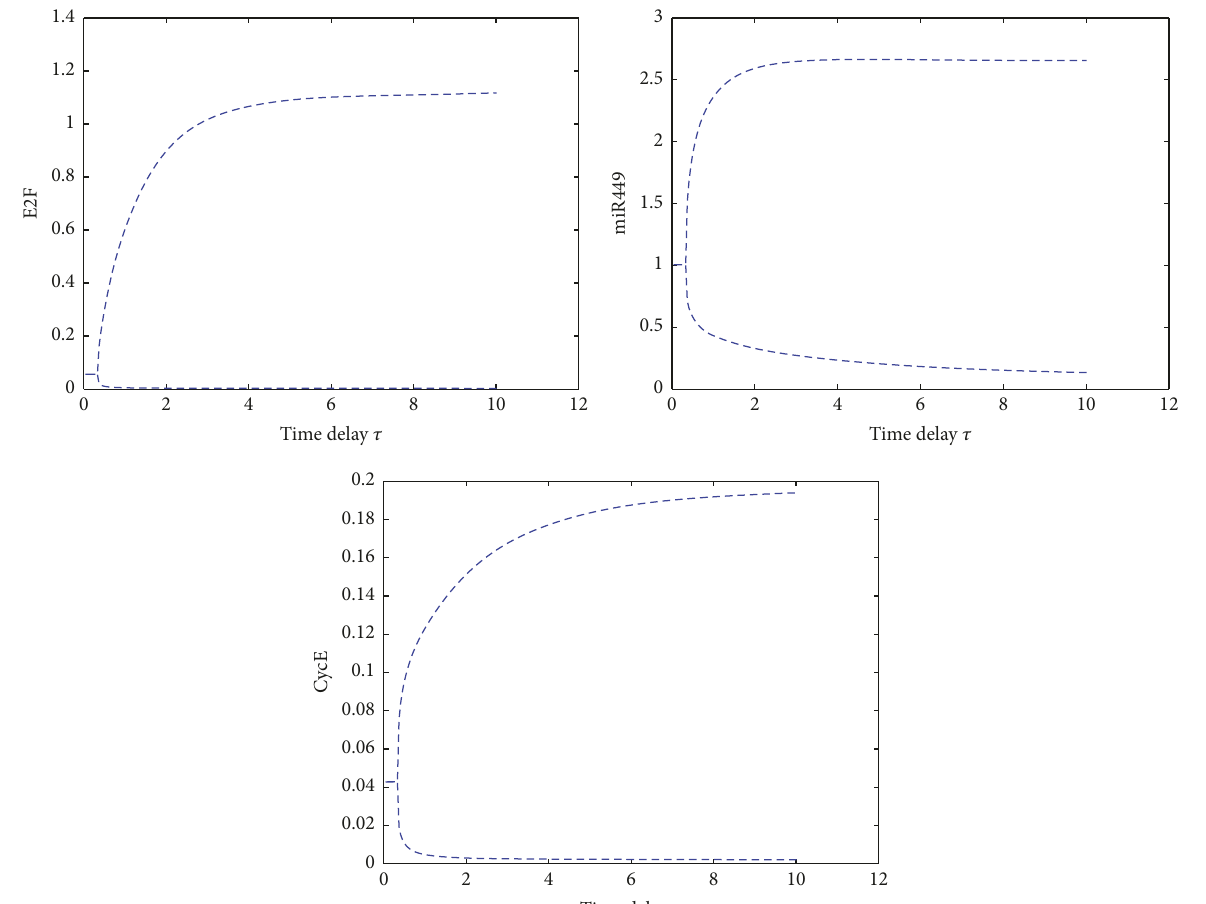
Figure 9: Bifurcation induced by time delay with 𝑆 = 3, 𝑘 21 = 2.5 . Assume initial conditions are 𝑥 1 = 1.2, 𝑥 2 = 0, 𝑥 3 = 0, 𝑥 4 = 0, 𝑥 5 = 0, 𝑥 = 0.55, 𝑥 = 0, 𝑥 = 0 , and 𝑆 = 3, 𝑘 = 2.5 6 7 8 21